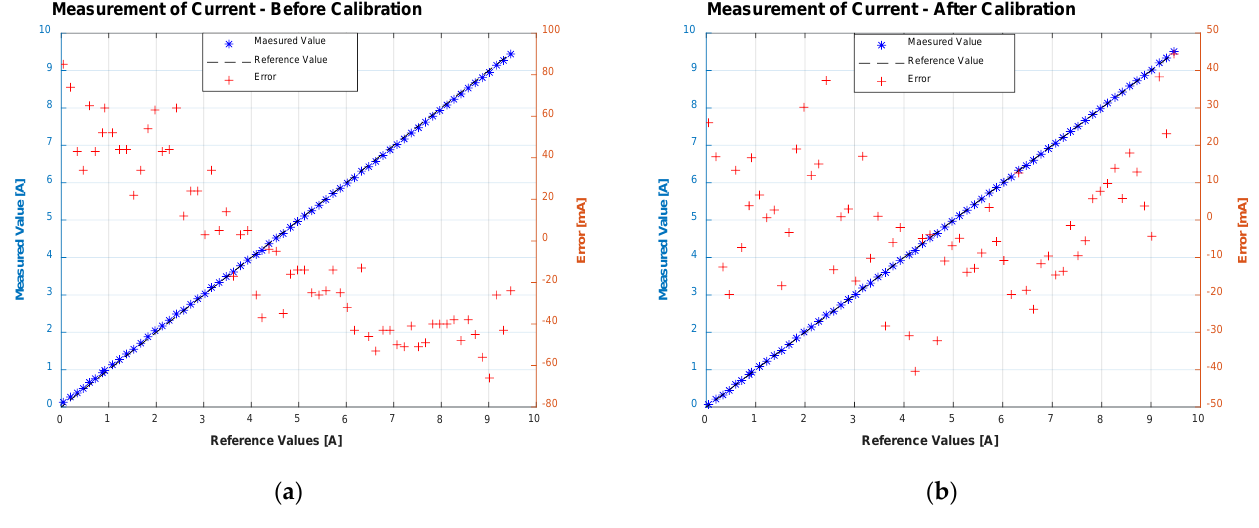
Figure 17. Measurement of Current: ( a ) Before Calibration; ( b ) After Calibration.